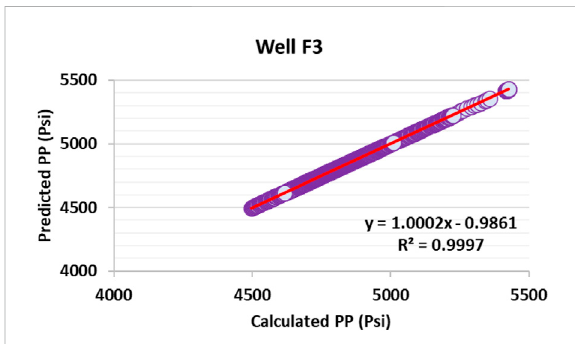
FIGURE 6 Cross plot for PP prediction by GS-GMDH based on wells F 1 and F 2 data points (1511 data points) for well F 3 (1200 data points).